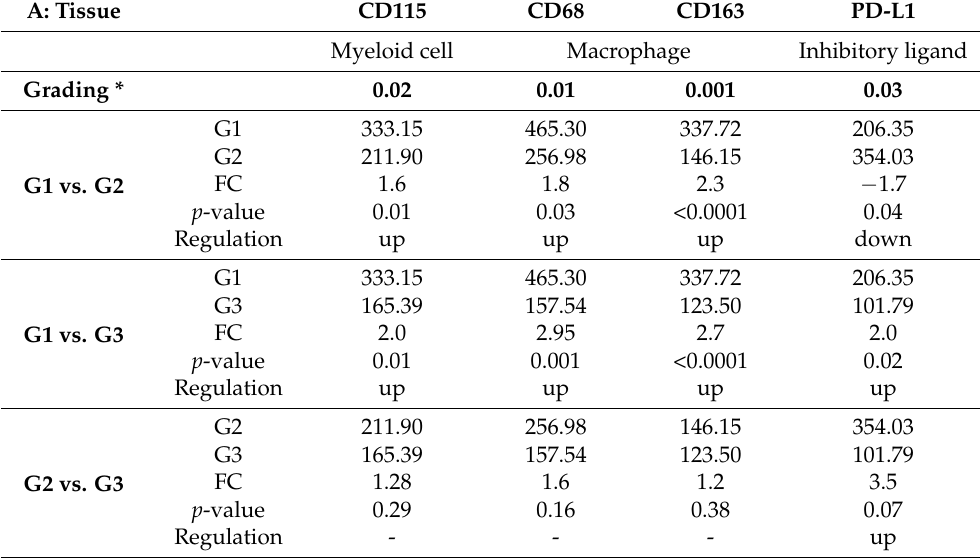
Table 5. Closer analysis of the changes in the expression levels of immune checkpoints, which showed significant differences in the * Kruskal–Wallis (KW) test, in relation to the increase in dedifferentiation (grading). Number of cases: G1 = 7, G2 = 54, G3 = 35. Statistically relevant changes are highlighted in